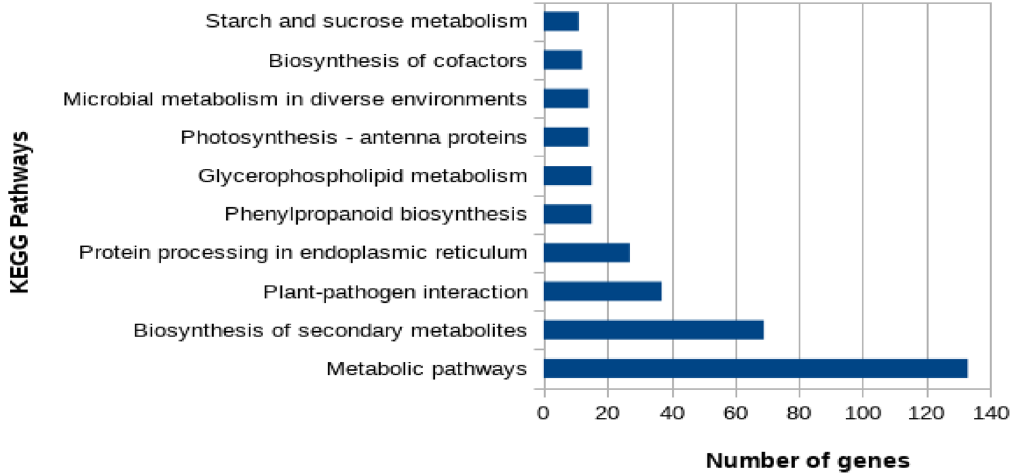
Figure 6. Graphical representation of the top 10 pathways of DEGs during heat stress treatment.